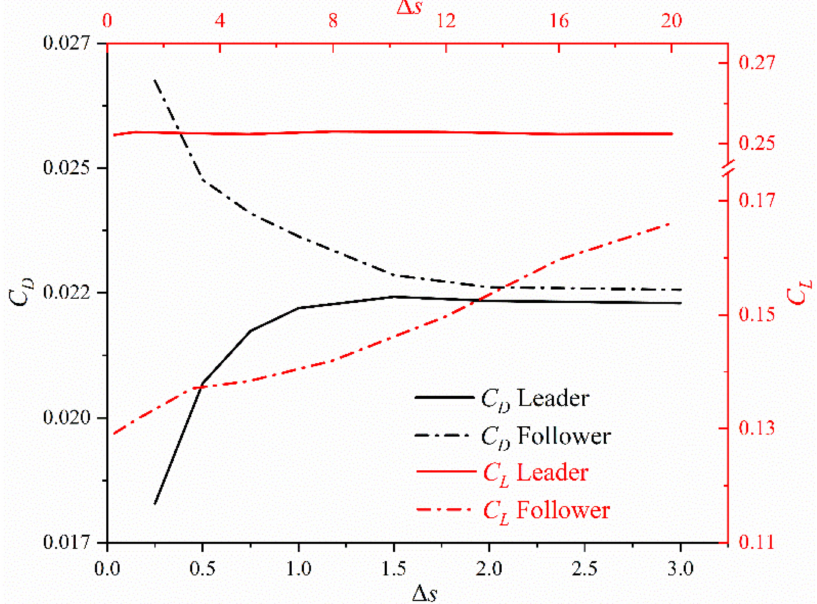
Figure 10. The variation of the gliding resistance coefficient and lift coefficient of two manta rays with distance at α = 4 ◦